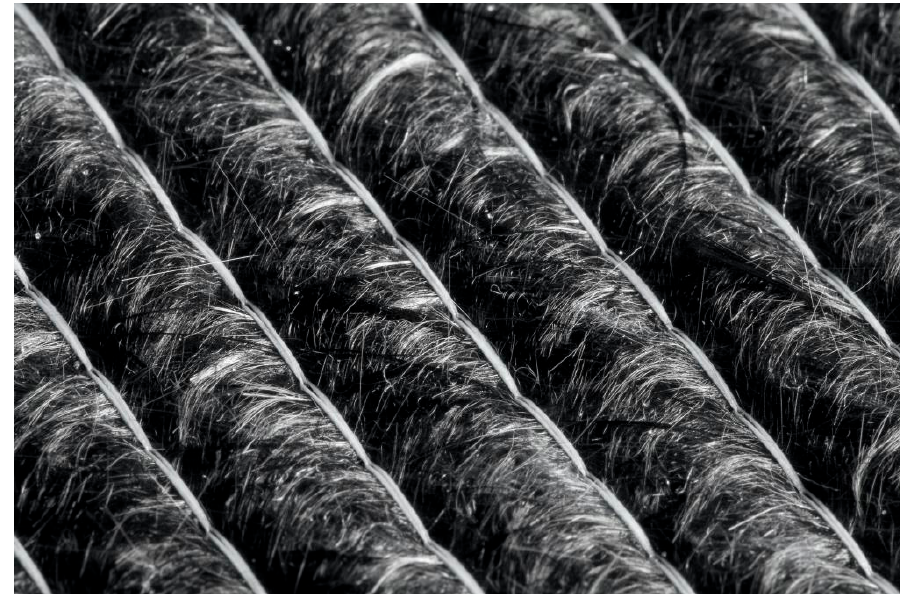
Figure 2. Carbon fiber recycling material for use in the BMW i3, e.g., the roof of the BMW i. According to the AVK-Report (Arbaitsgemeinschaft Verstearktekunststoffe, Federation of Reinforced Plastics) dry carbon fibers and prepregs, impregnated with resin but not yet cured, represent the largest waste. “For this, our major topic is plastic injection moulding with recyclate”, Brúch (BMW Group—company speaker). One example is the center console of the current MINI, which is manufactured with granulate from chopped CFRP parts [14].